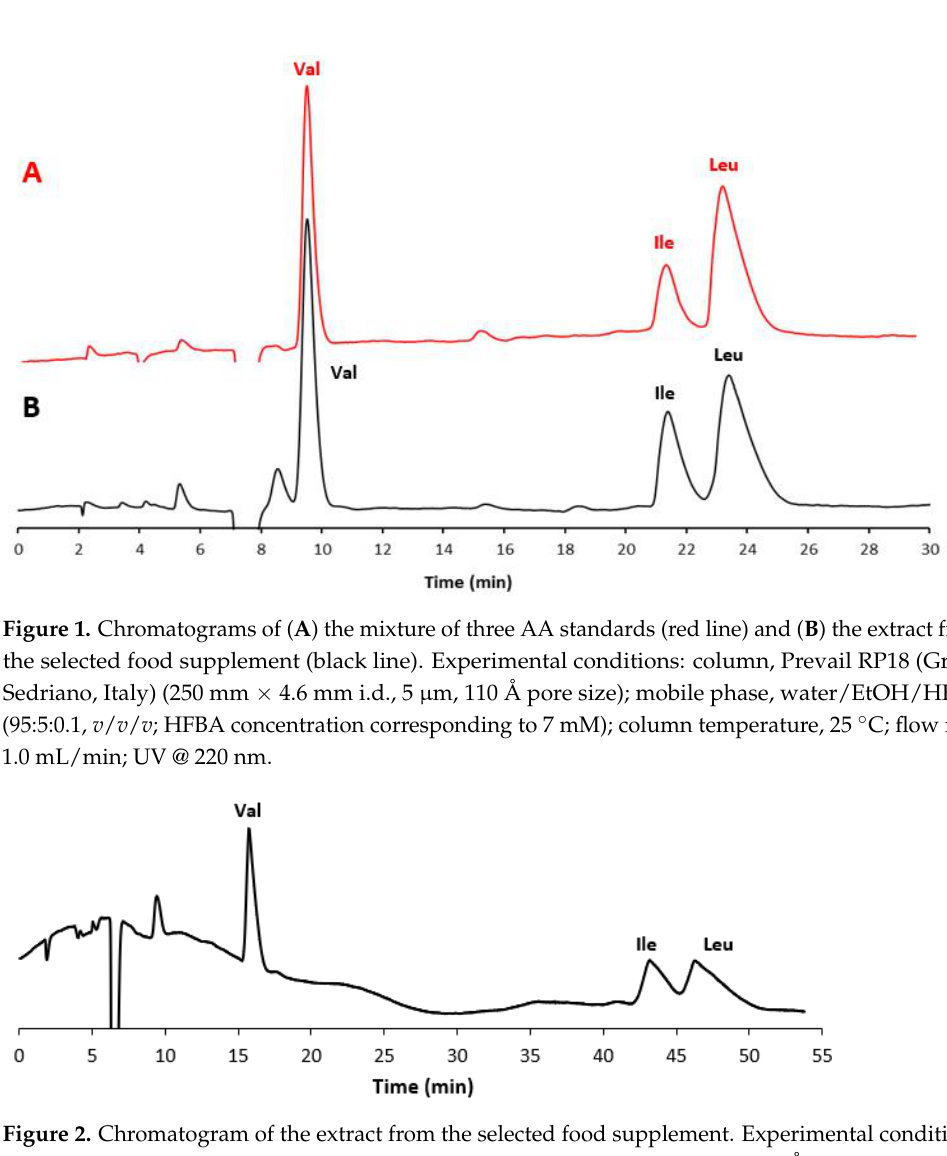
Figure 2. Chromatogram of the extract from the selected food supplement. Experimental conditions: column, Prevail RP18 (Grace, Sedriano, Italy) (250 mm × 4.6 mm i.d., 5 μm, 110 Å pore size); mobile phase, water with 0.1% ( v / v ) HFBA (7 mM); column temperature, 45 °C; flow rate, 1.2 mL/min; UV @ 220 nm.